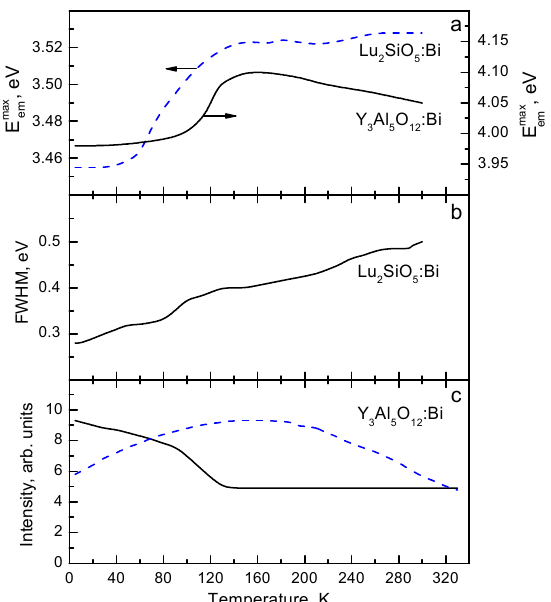
Figure 2. ( a ) Absorption spectra of Lu 3 Al 5 O 12 :Bi (solid line) and Y 3 Al 5 O 12 :Bi (dashed line) at 295 K. Excitation spectra (normalized) of ( b ) Lu 3 Al 5 O 12 :Bi and ( c ) Y 3 Al 5 O 12 :Bi measured at 80 K for different emission spectra regions shown in the legends. Based on the data reported in [16–18], presented with the publisher’s permission.